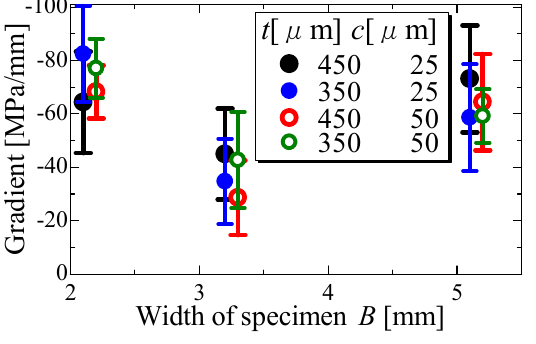
Figure 9. Relationship between specimen width and the gradient of the approximated